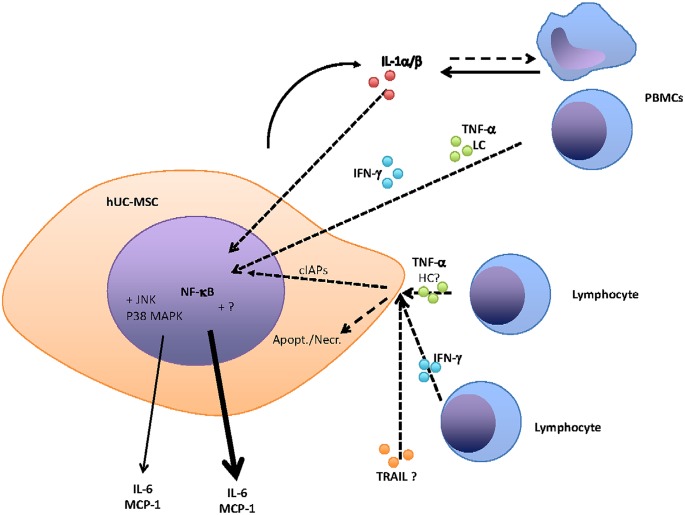
Scheme of interactions between hUC-MSCs and PBMCs.Cytokine receptors are not presented, LC for Low Concentration, HC for High Concentration. Thick full lines are for cytokine production. Dashed line are for cell stimulation.